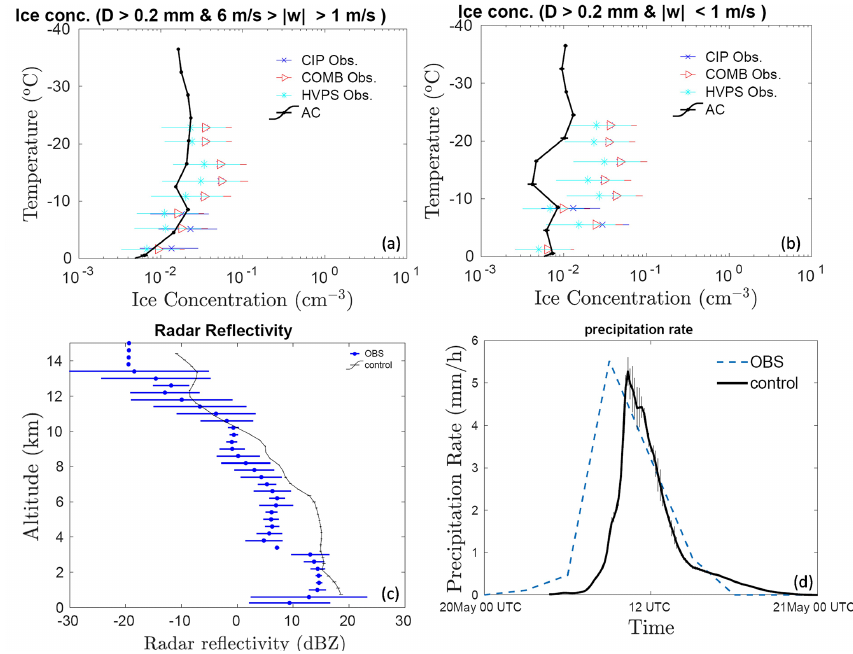
Figure 3. Comparison of the control simulations by AC with aircraft observations for the ice number concentration of all particles > 0 . 2(NT200)mm in the maximum dimension of all microphysical species (cloud ice, graupel/hail, and snow), averaged over (a) convective (6ms − 1 > | w | > 1ms − 1 ) and (b) stratiform ( | w | < 1ms − 1 ) regions. (c) The vertical profile of simulated radar reflectivity conditionally av- eraged over all regions of significant reflectivity ( > − 20dBZ) at each level is compared with observations from ground-based radars. The temperature corresponding to each altitude is mentioned on the right axes, and the (d) predicted precipitation rate (mmh − 1 ) is compared with ground observations at the SGP CF. All the vertical profiles shown here are averaged for the whole domain. The error bars were estimated based on five ensemble